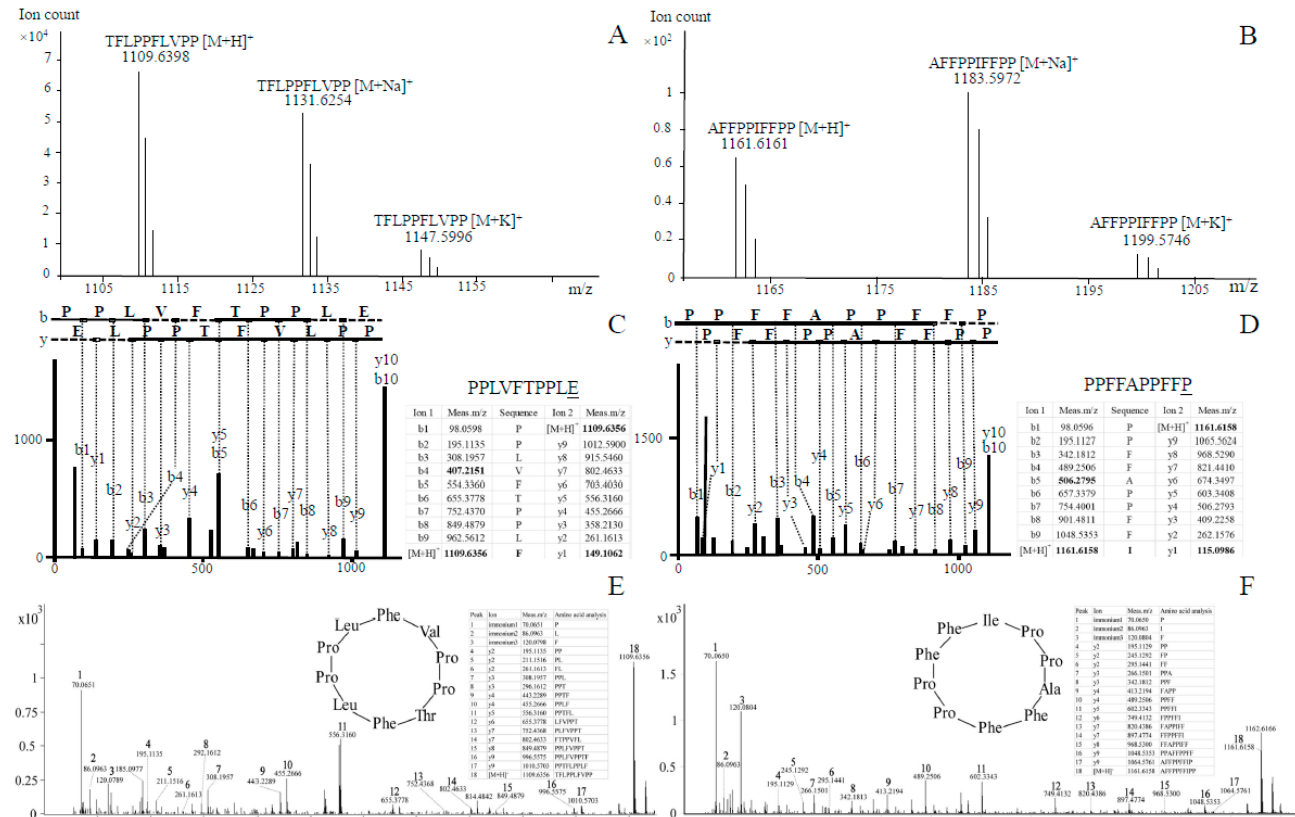
Figure 3. LC–HRMS and the amino acid composition of the cyclized core peptide sequences of TFLPPLFVPP and AFFPPFFIPP (CylG1 and CylG2, respectively) in Amanita subjunquillea . Positive LC–HRMS spectra of CylG1 ( A ) and CylG2 ( B ), with [M+Na] + and [M+K] + adduct ions indicated. ( C , D ) Amino acid composition analysis through the Center for Computational Mass Spectrometry (CCMS) for CylG1 and CylG2, with b- and y-type fragment ions shown (bold fonts were manually added for ions not recognized by the website); predicted linear peptide sequences are shown above the inserted tables (the last amino acids are underlined as they were erroneous). ( E , F ) Manual analyses of recognized fragment ions for CylG1 and CylG2 with inserted tables of matched amino acids; immonium ions are shown when present. The determined cyclic peptides are shown as